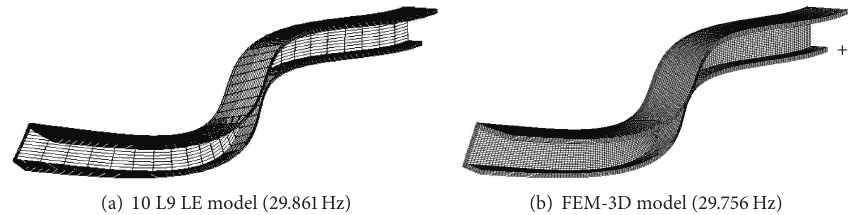
Figure 10: Eighth modal shape of the C-shaped beam.